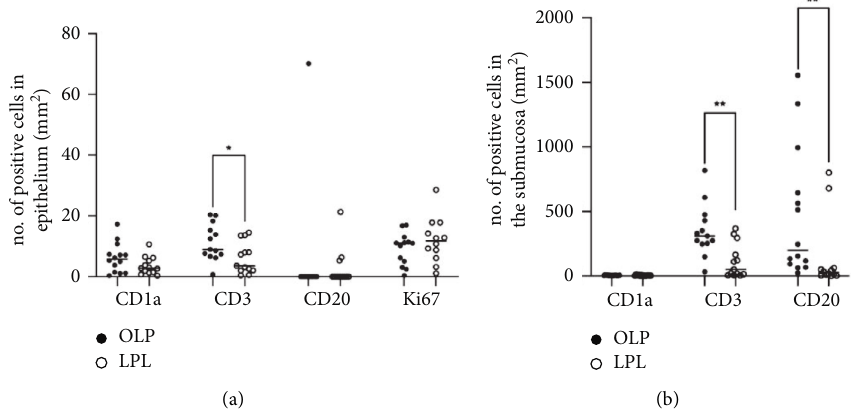
Figure 4: Numbers of cells expressing CD1a, CD3, CD20, and Ki67 in (a) epithelium and (b) submucosa of patients with oral lichen planus (OLP; closed circles) and leukoplakia (LPL; opened circles). Each symbol denotes a patient and the horizontal bars denote the median values. ∗ p < 0 . 05; ∗ ∗ p < 0 . 01 using the Mann–Whitney (U)-test.